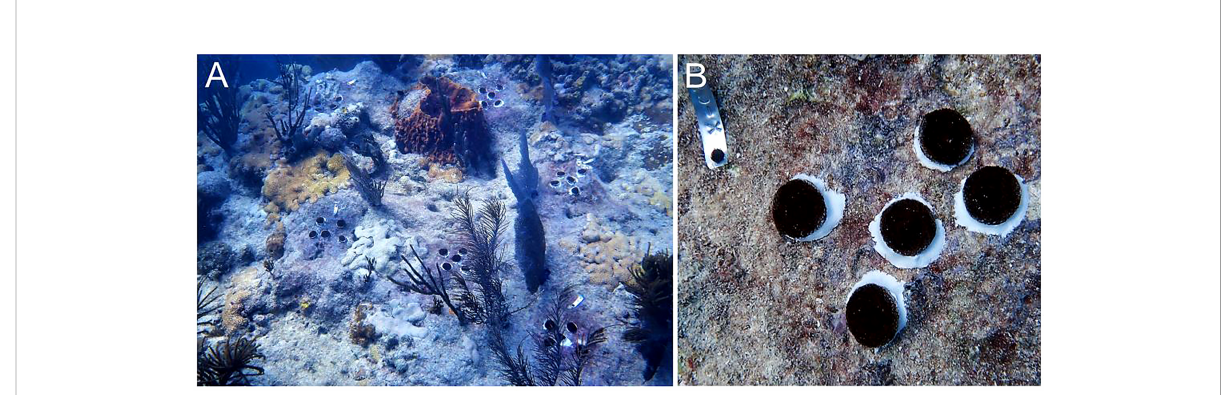
FIGURE 6 Active restoration using sexual recruits produced via ASR. (A) Outplant event where each cluster of corals represents a different genet from the same or different family. (B) One method of outplanting involves fragmenting a single genet into fi ve clonal replicates, which are then outplanted as a cluster in order to form (via fusion) a larger colony faster; every outplant or cluster is tagged for monitoring purposes. Source: Erich Bartels.